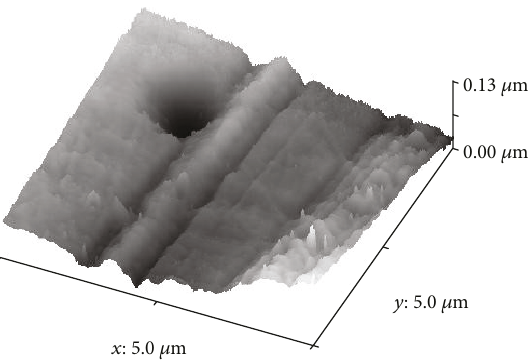
Figure 4: Atomic force micrograph of the HEC/PAAm xerogel.